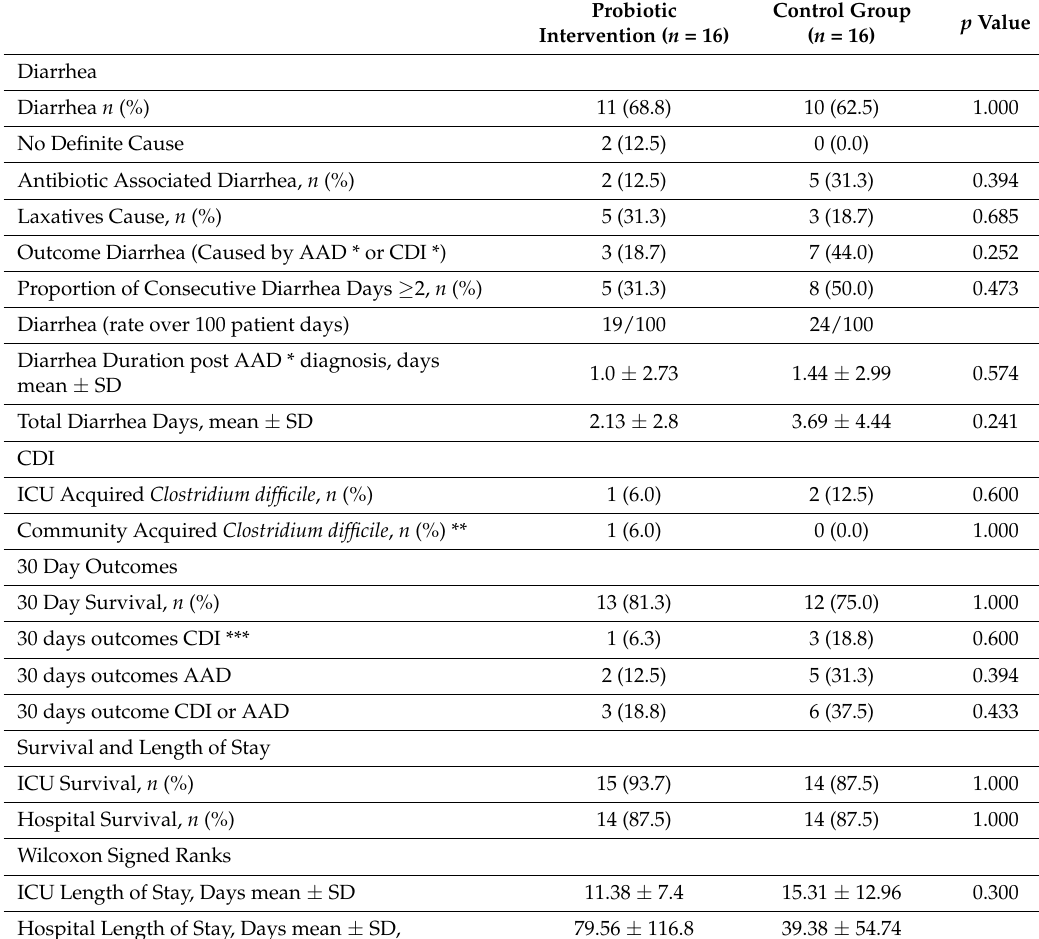
Table 3. Outcome